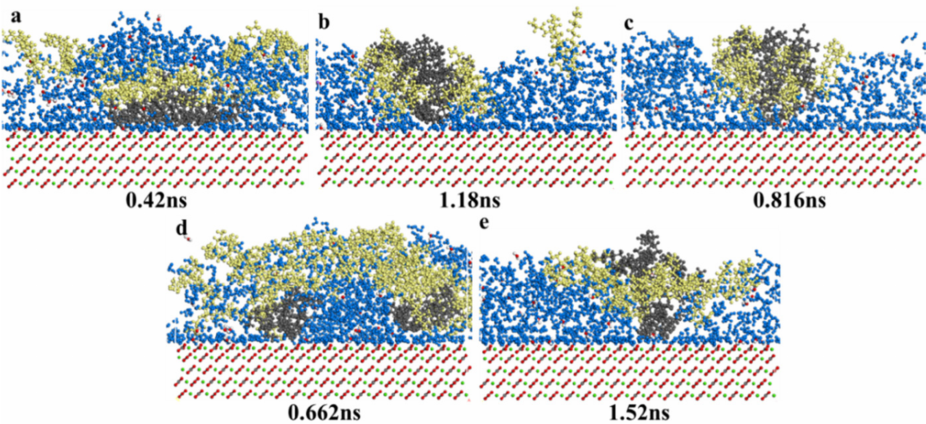
Figure 9. Consecutive snapshot of desorption of saturates from a modeled calcite surface immersed in ( a ) CTAB; ( b ) SDS; ( c ) TX-100; ( d ) Sophorolipid; ( e ) Rhamnolipid-water system just right. Blue = water; black = saturates; red = calcite surface; yellow =